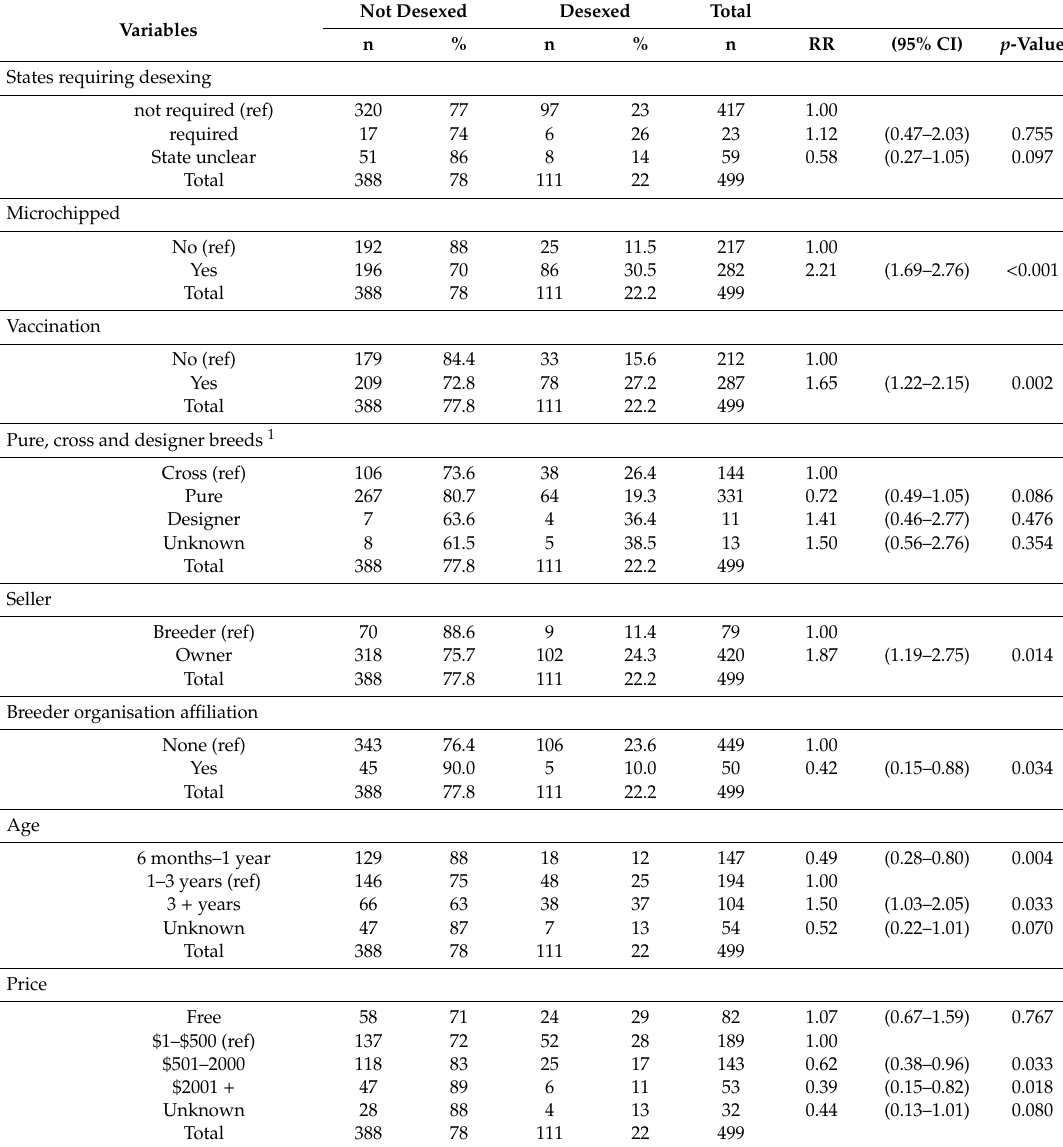
Table 5. Univariate analysis of factors associated with dogs being desexed prior to sale from two individual webscrapes from Gumtree dog and puppy advertisements (25 March and 8 April 2019) in Australia. States were amalgamated into states which regulated desexing (QLD, VIC and SA), and states which did not regulate desexing. Australian Capital Territory and Northern Territory were excluded due to insu ffi cient counts. Rescue and shelter advertisements were excluded due to interactions with desexing. Predictors have been grouped for ease of interpretation with the reference indicated with a (ref) and a relative risk (RR) of 1. A p -value of < 0.05 was considered